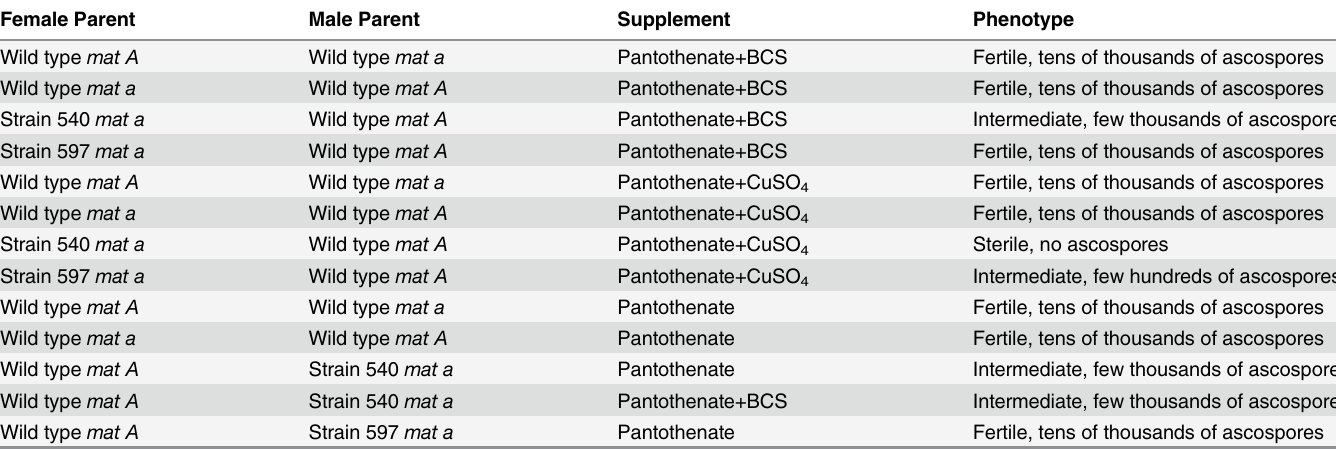
Table 4. Sexual cycle